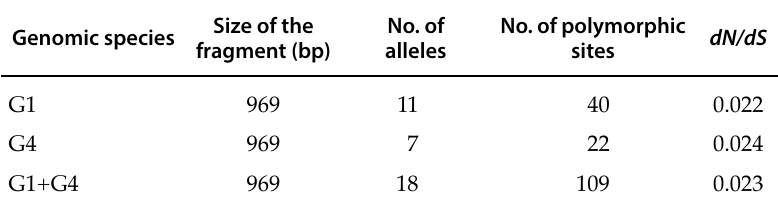
Table 3. Analysis of the rec A gene fragment in the Agrobacterium tumefaciens biovar 1 soil